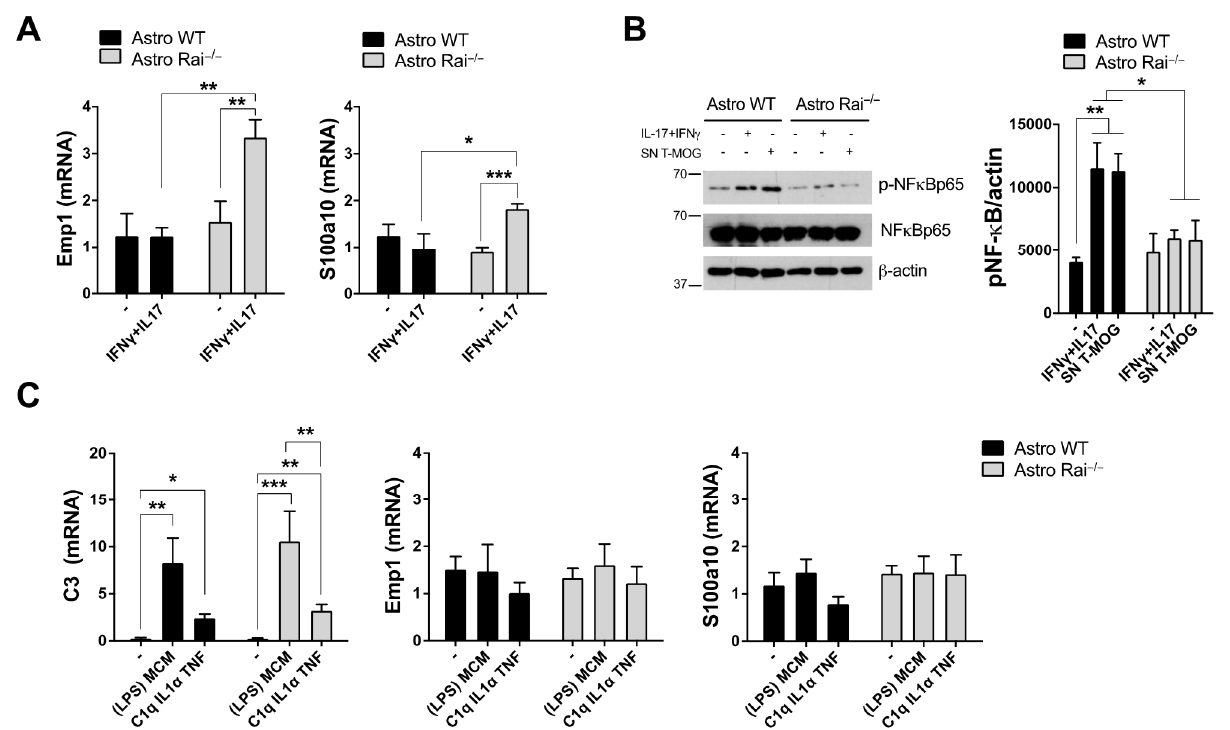
Figure 1. Rai signaling controls astrocyte reaction to soluble factors secreted by MOG-specific T cells, but not by microglia. ( A ) qRT-PCR analysis of Emp1 and S100a10 transcripts in WT (Astro WT) and Rai −/− (Astro Rai −/− ) astrocytes untreated (-) or treated for 24 h with a combination of IFNγ (10 ng/mL) and IL-17 (50 ng/mL) (IFNγ + IL-17). Data are presented as mean value ± SD ( n = 4); ( B ) Immunoblot analysis of phosphorylated NF-κB in lysates of WT (Astro WT) and Rai −/− (Astro Rai −/− ), astrocytes untreated or treated for 15 min at 37 °C with culture supernatants from MOG-specific T cells or as in ( A ). Actin and NF-κB were used as loading control. The histogram shows the quantification by densitometric analysis of the levels of phosphorylated NF-κB relative to actin ( n = 4); ( C ) qRT-PCR analysis of C3, Emp1, and S100a10 transcripts in WT (Astro WT) and Rai −/− (Astro Rai −/− ), astrocytes untreated or treated for 24 h at 37 °C with culture supernatants from LPS-activated microglia (LPS-MCM) or with a combination of IL-1α (3 ng/mL), TNF (30 ng/mL), and C1q (400 ng/mL). Data are presented as mean value ± SD ( n = 5 for LPS-MCM, n = 3 for IL-1α, TNF, and C1q). *** p < 0.001, ** p < 0.01, * p < 0.05.